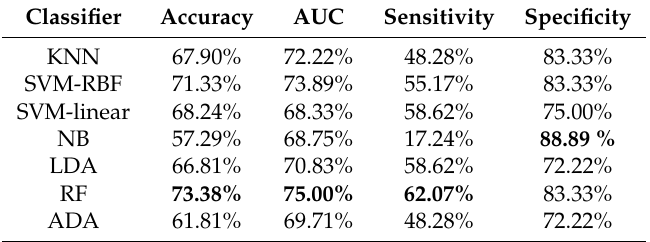
Table 3. Classification performance with features merged from all tasks. The best results are in bold.